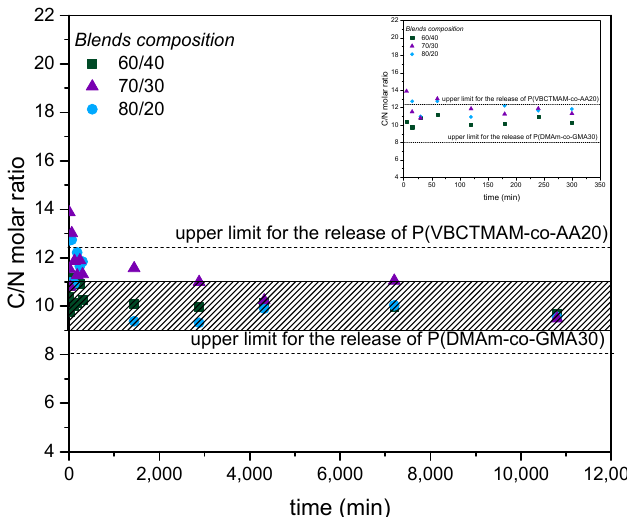
Figure 5. Evolution of the C / N molar ratio, determined from the TOC / TN measurements, after immersion of the coated nets P(VBCTMAM-co-AA20) / P(DMAm-co-GMA30) 60 / 40, 70 / 30, 80 / 20 w / w in 3.5%( w / v ) NaCl solution for seven days.